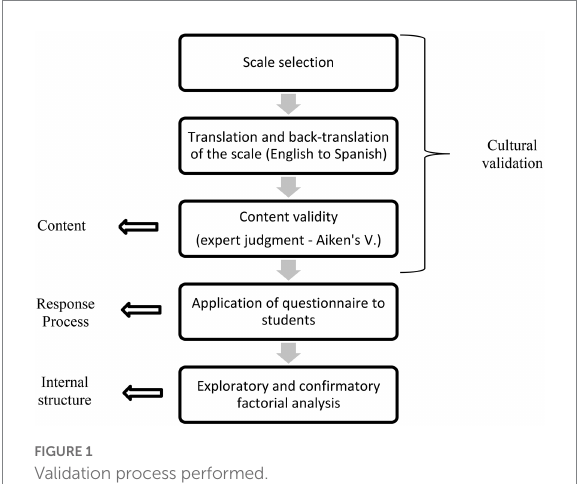
FIGURE 1 Validation process